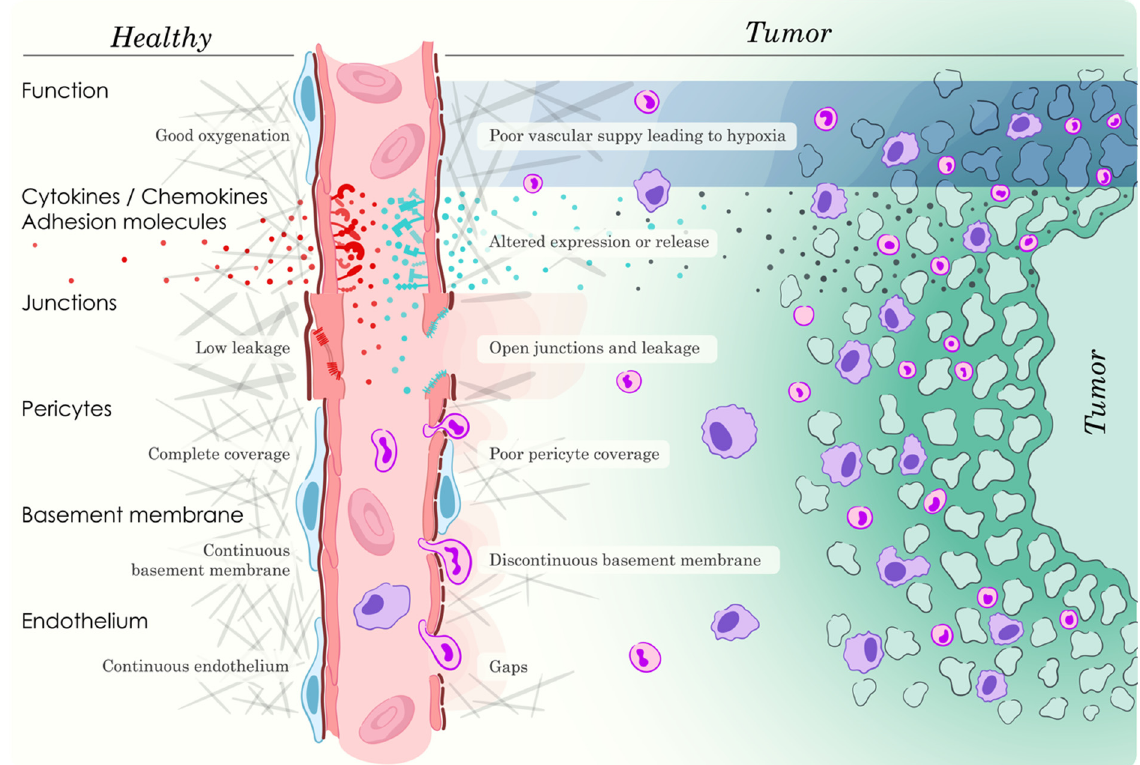
Figure 1. Vascular regulation of tumor IC response. Numerous processes are involved in the ability of the vasculature to influence the tumor immune response and some are illustrated in this figure. Vascular function determines the degree of tumor hypoxia, which in turn will influence cytokine/chemokine production and immune response. Oxygenation is a function of flow and oxygen diffusion, which in turn depend on vascular density and architecture. EC adhesion molecule and cytokine/chemokine expression together with the degree of junction disassembly causing open junctions will impact IC extravasation and this may be selective for certain IC or non-selective for all IC. The degree of junction disassembly will in turn depend on signaling events affecting junction protein phosphorylation and intracellular localization, focal adhesions and the cytoskeleton. Pericyte and basement membrane coverage together with gaps in EC lining are also important factors. HEV are not specifically illustrated but their abundance plays a role for tumor immune response. Eventually, the parameters mentioned will influence the recruitment of pro-tumoral and anti-tumoral IC, both adaptive and acquired, and the balance of pro-tumoral and anti-tumoral cues will decide the final immune response impacting tumor expansion or regression.